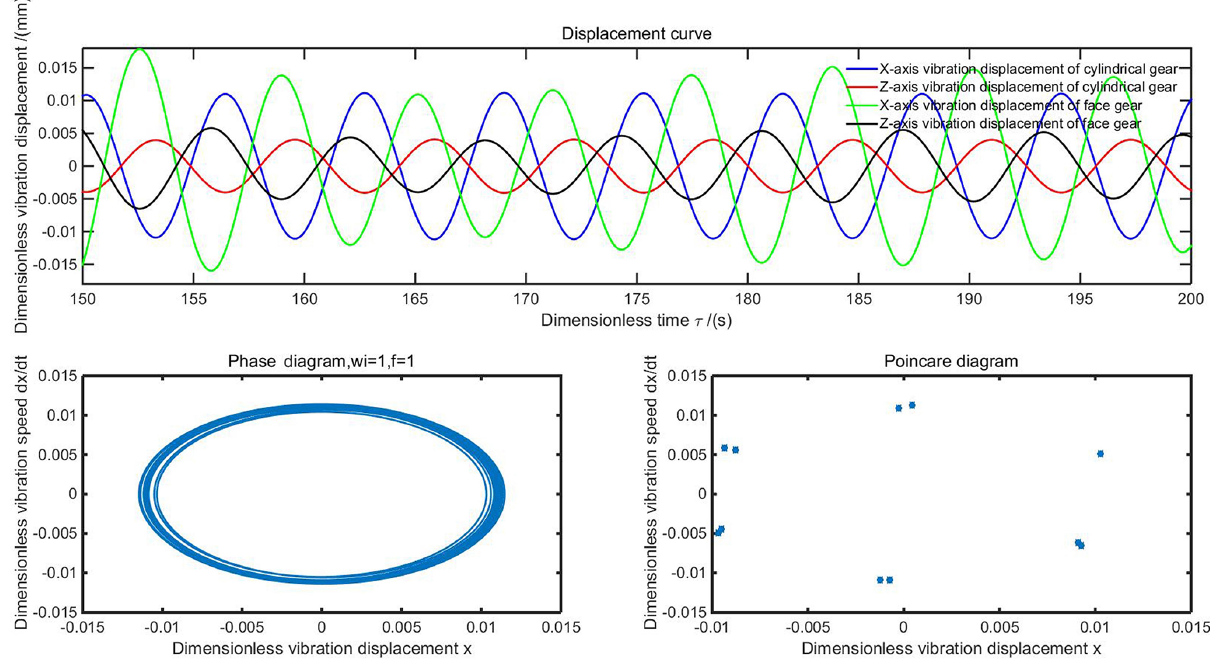
Figure 3. Displacement, phase, and Poincare diagrams of linear system.